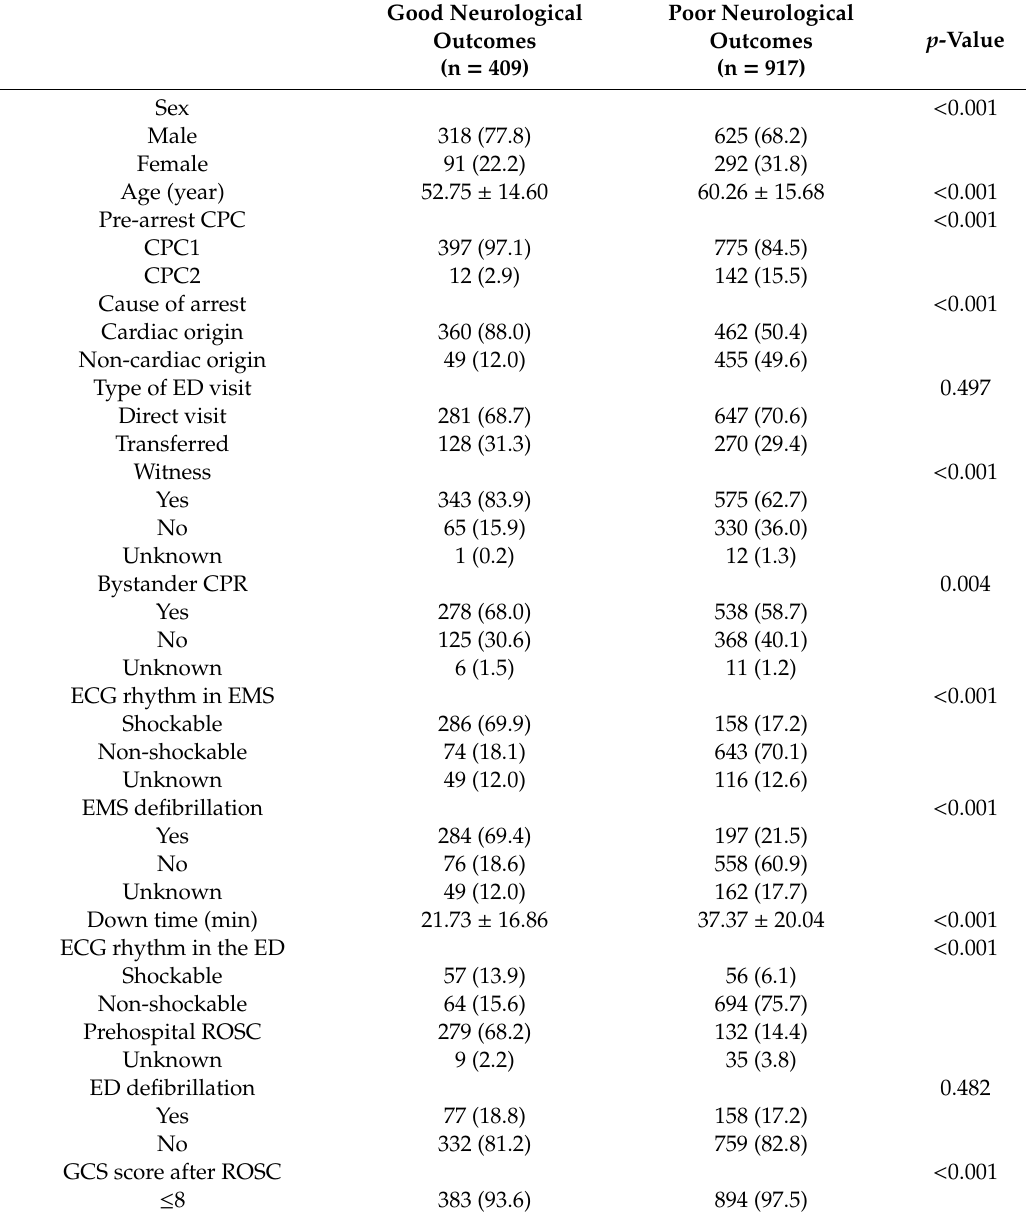
Table 2. Univariate analysis for neurological outcomes after 6 months. Good